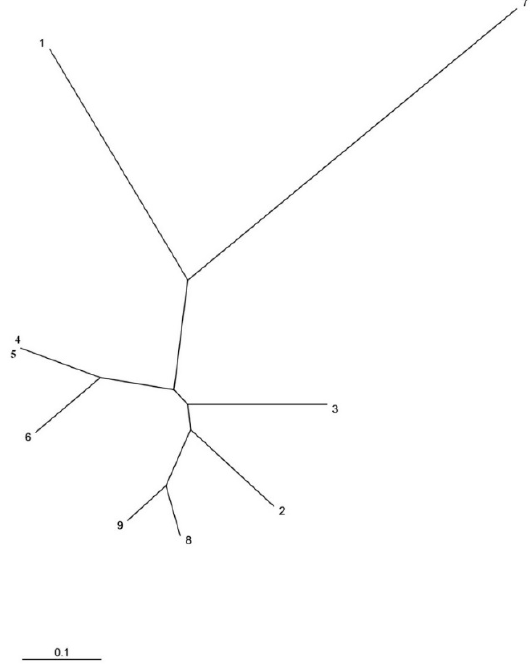
Figure 1. Unrooted neighbor-joining molecular phylogenetic tree of the nine accessions of the Ardhaoui barley landrace accessions under study based on six polymorphic genomic SSR markers [27]. Phenetic relationships were derived from genetic distances [28].